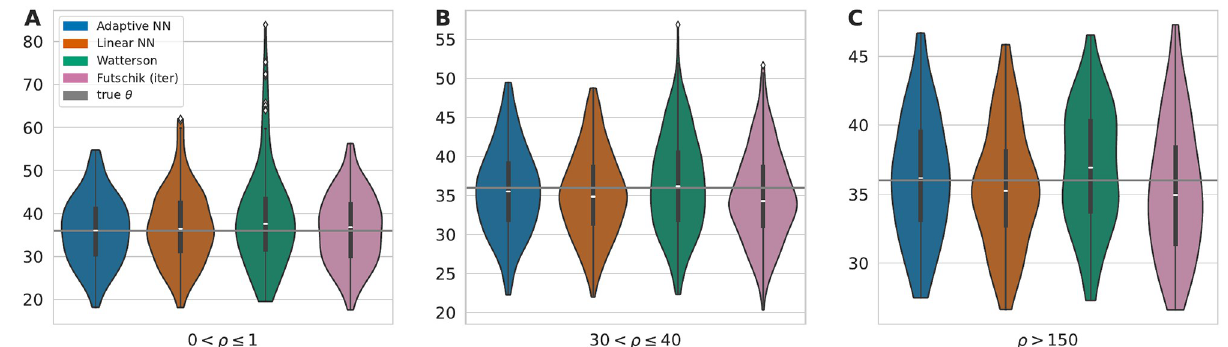
Fig 6. Estimates of θ in regions of chr2 with low, intermediate, and high recombination. The mean recombination rates of disjoint 70kb windows of chr2 were calculated and estimates for regions with low (0 < ρ � 1) (A), medium (30 < ρ � 40) (B) and large ( ρ > 150) (C) recombination rates are shown in a Violin plot. The white marker in the box of the violins visualizes the median. The true mutation rate θ = 36.12 is shown as a grey line.